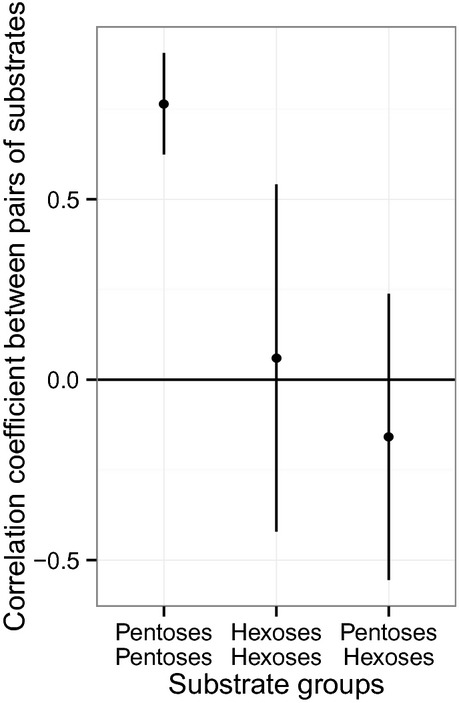
Genetic correlation coefficient between pairs of sugars grouped by number of carbon (mean value with standard deviation). Pentoses and hexoses are compared together (two values at left) or with one another (value at right).